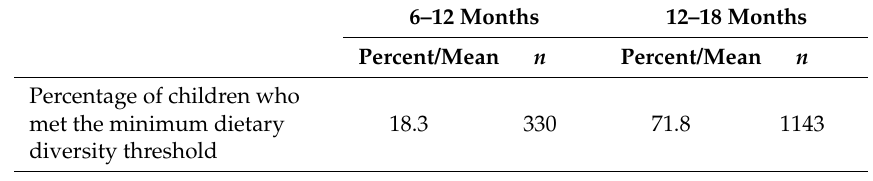
Table 3. Descriptive statistics of dietary diversity in infants aged 6–18 months in rural China ( n =